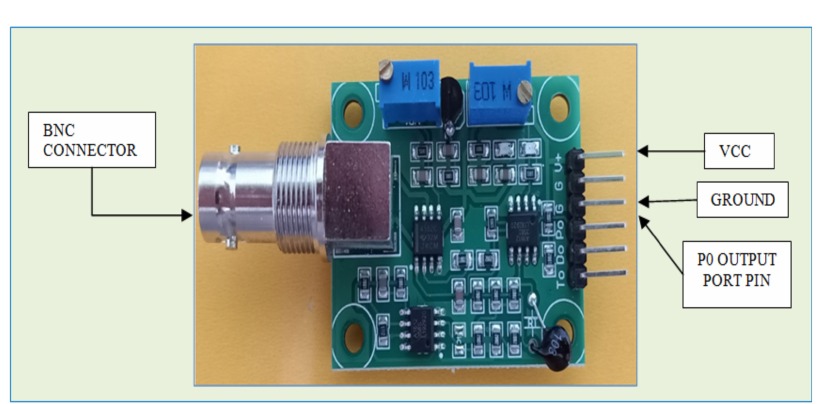
Figure 9. The ph sensor breakthrough